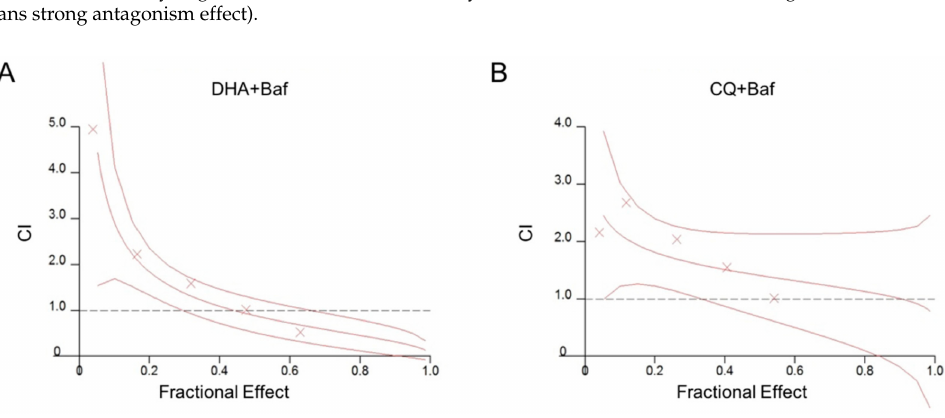
Figure 3. E ff ects of the antimalarial drugs DHA / CQ combined with Baf-A1 against P. f 3D7 growth in vitro. ( A ) CI of DHA combined with Baf-A1, ( B ) CI of CQ combined with Baf-A1, combination index (CI) represents the interaction e ff ect in the presence and absence of inhibitor. CI < 1, = 1, and > 1 indicates synergism, additive, and antagonism e ff ect,